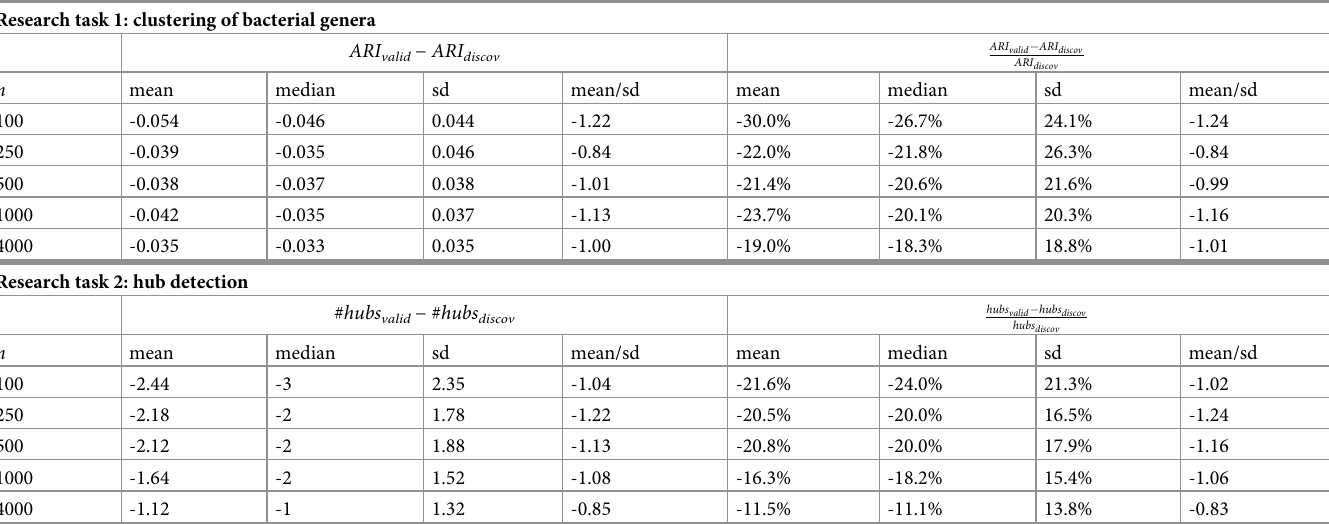
Table 1. For research tasks 1 and 2: Mean, median, and standard deviation (over 50 samplings of discovery/validation data) of the difference (both unscaled and scaled) between the value of the evaluation criterion on the validation data and the corresponding value on the discovery data. Additionally, the effect size (mean divided by standard deviation) is reported. ARI denotes the best ARI on the discovery data and ARI the ARI resulting from the corresponding method combination discov valid on the validation data. The quantities # hubs discov , # hubs valid (number of hubs) are defined analogously.